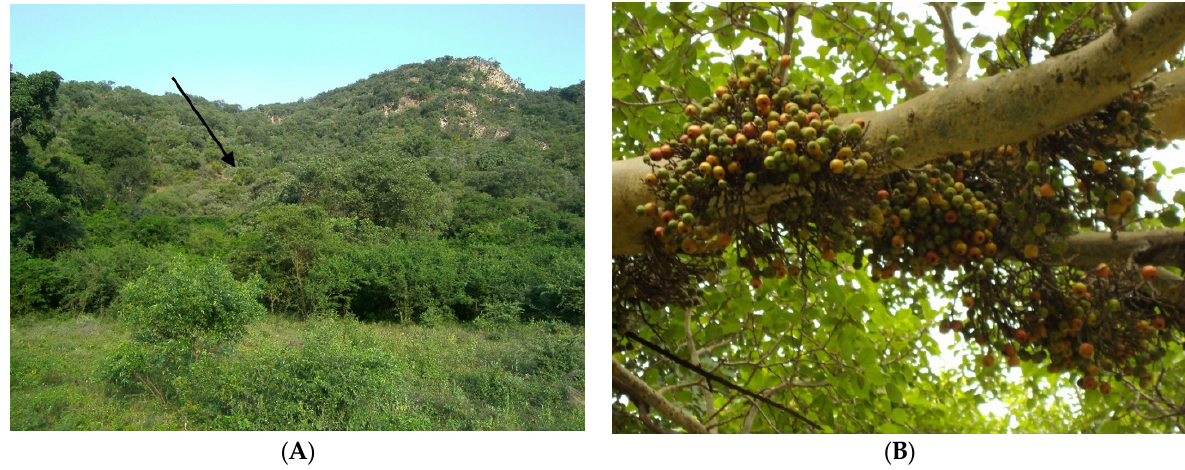
Figure 1. Location of entry to Matlapitsi cave (indicated by arrow) inhabiting R . aegyptiacus colony, Matlapitsi Valley, Limpopo province, South Africa ( A ); Cape fig tree with fruits, which is a preferred food for R . aegyptiacus ( B ).